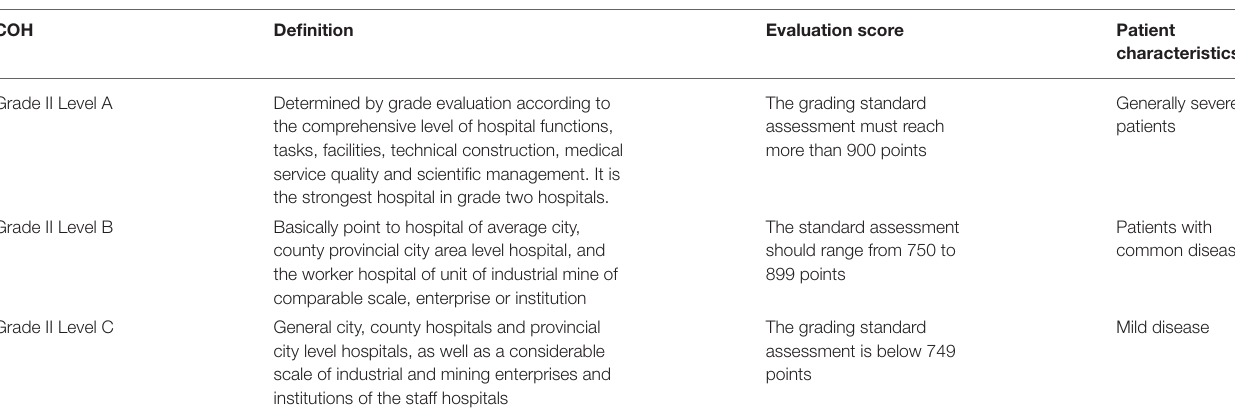
TABLE 2 | The characteristics of different classifications of hospitals